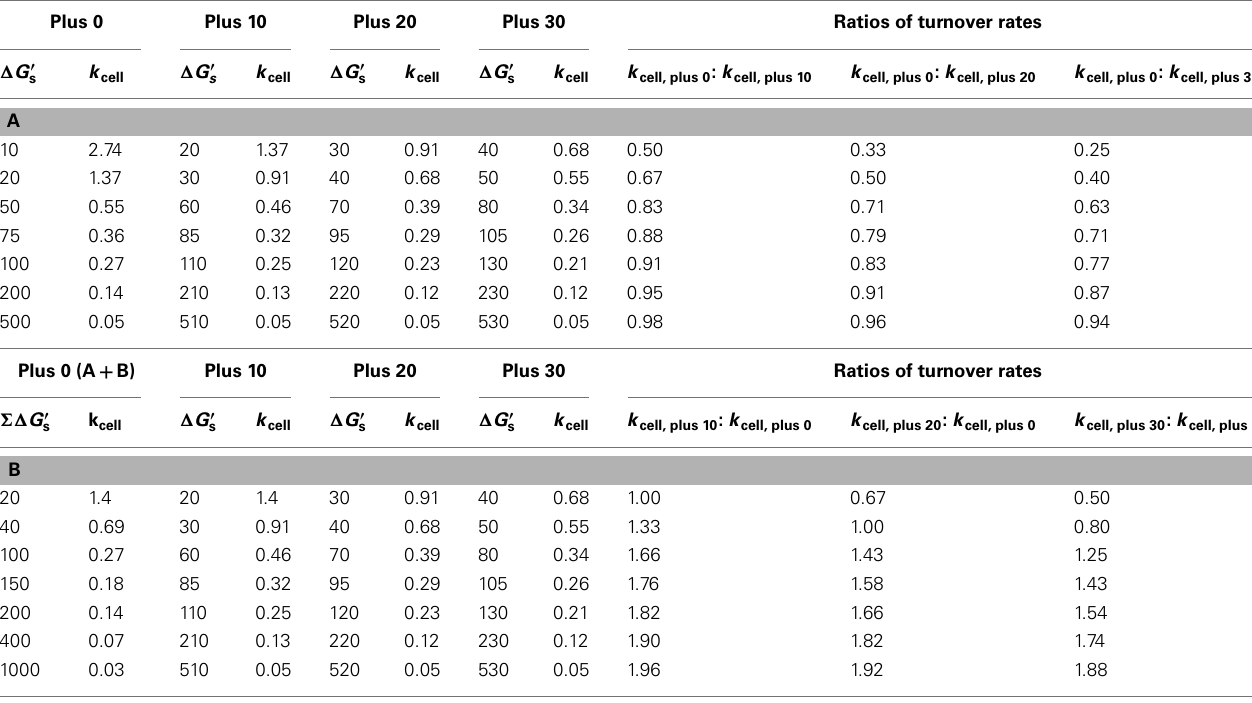
Table 6 | Overview of cell-specific substrate turnover rates ( k cell ; fmol cell − 1 year − 1 ) required to meet the theoretical maintenance